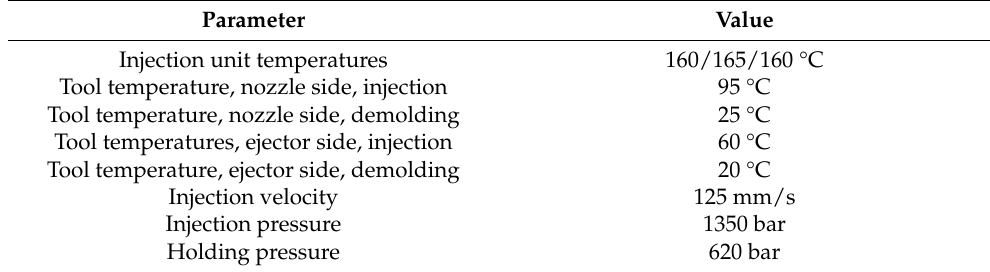
Table 1. Injection molding parameters used.